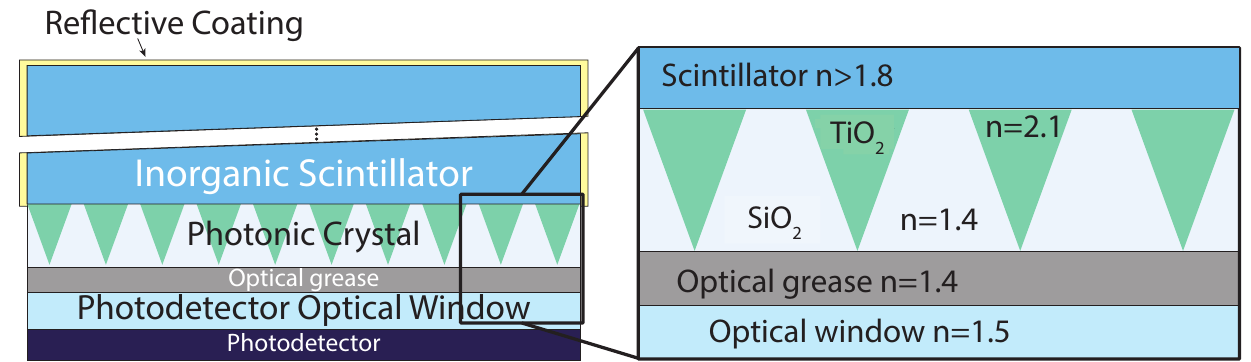
Figure 5. Proposed photonic crystal solution: The scintillator is covered by reflective material and the novel Photonic Crystal (PhC) structure is implemented on the output surface. The PhC is composed of titanium oxide nanocones surrounded by a buffer layer of silicon oxide with a refractive index of about 1.4. The solution allows a stable coupling with the photodetector by means of a refractive index matching material, such as grease.